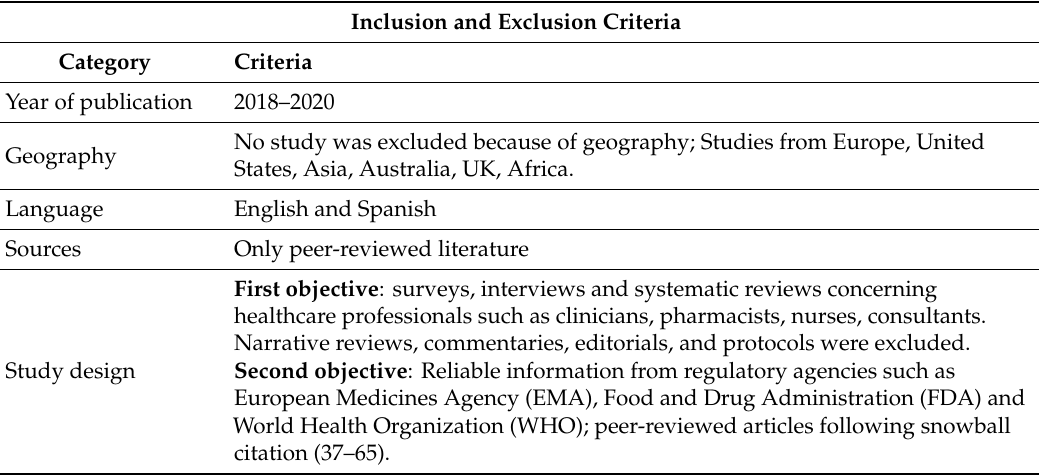
Table 1. Inclusion and exclusion